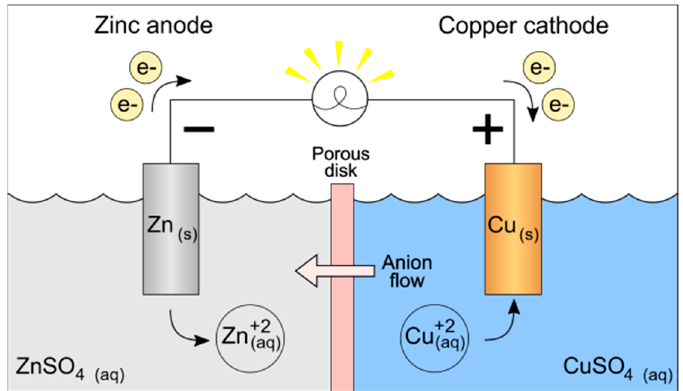
Figure 11. Working principle of a galvanic cell. CC BY-SA [29].